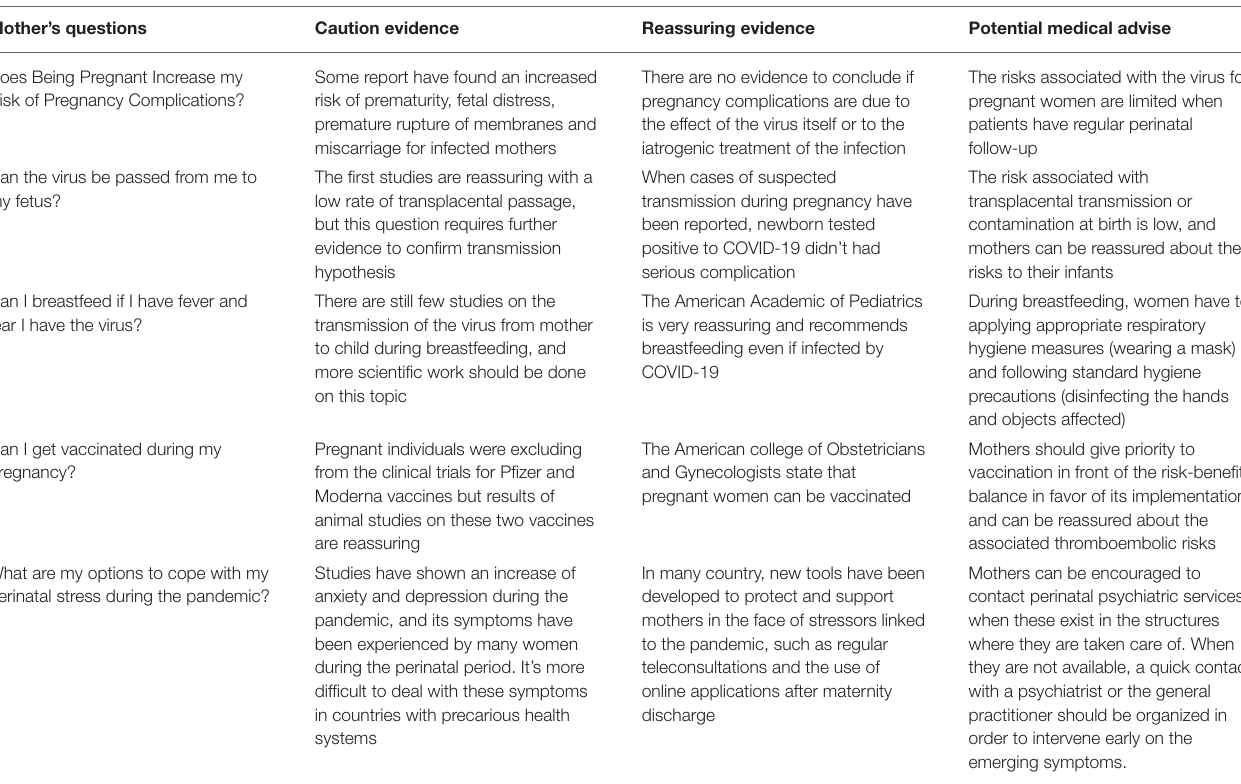
TABLE 1 | Questions frequently asked by mothers during COVID-19